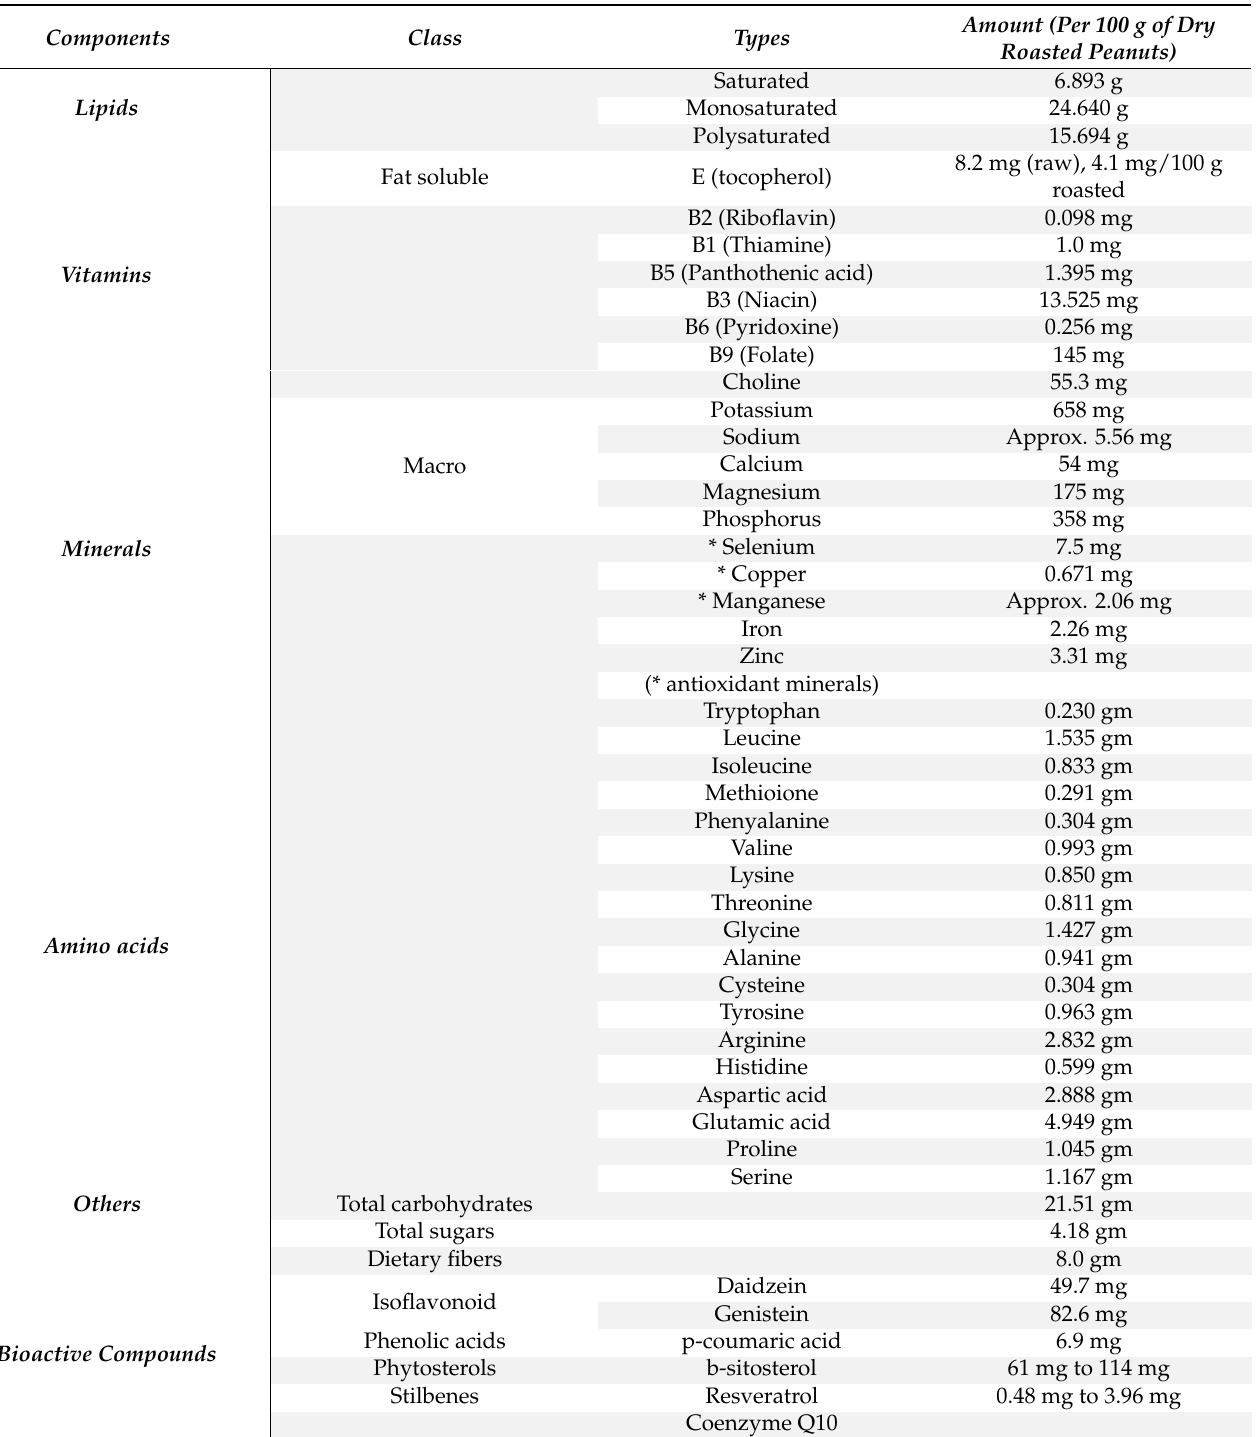
Table 2. Chemical and nutritional composition of